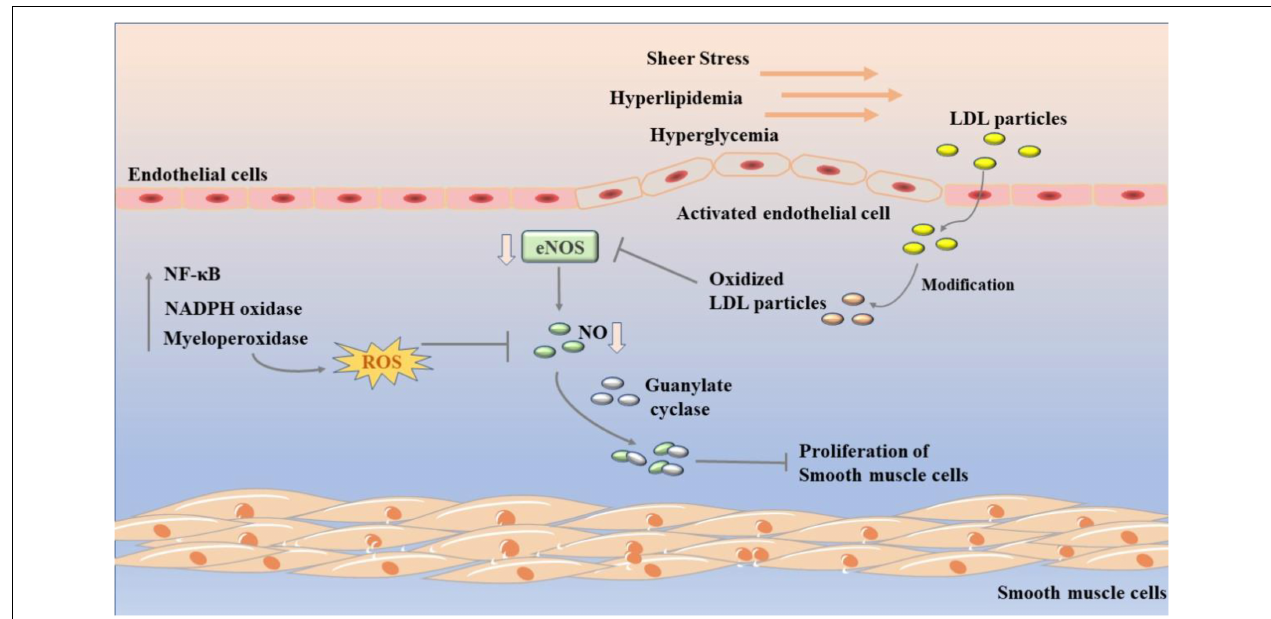
FIGURE 1 | Development of endothelial dysfunction in atherosclerosis. Sheer stress, hyperlipidemia, and hyperglycemia leads to endothelial dysfunction. LDLs will accumulate in the subcutaneous space of the artery wall and oxidize to form oxLDL. It further decreases the activity of eNOS, which in turn reduce the content of NO. The nuclear transcription factor kappa B (NF- κ B), NADPH oxidase (NOX), and myeloperoxidase (MPO) are related to its process.